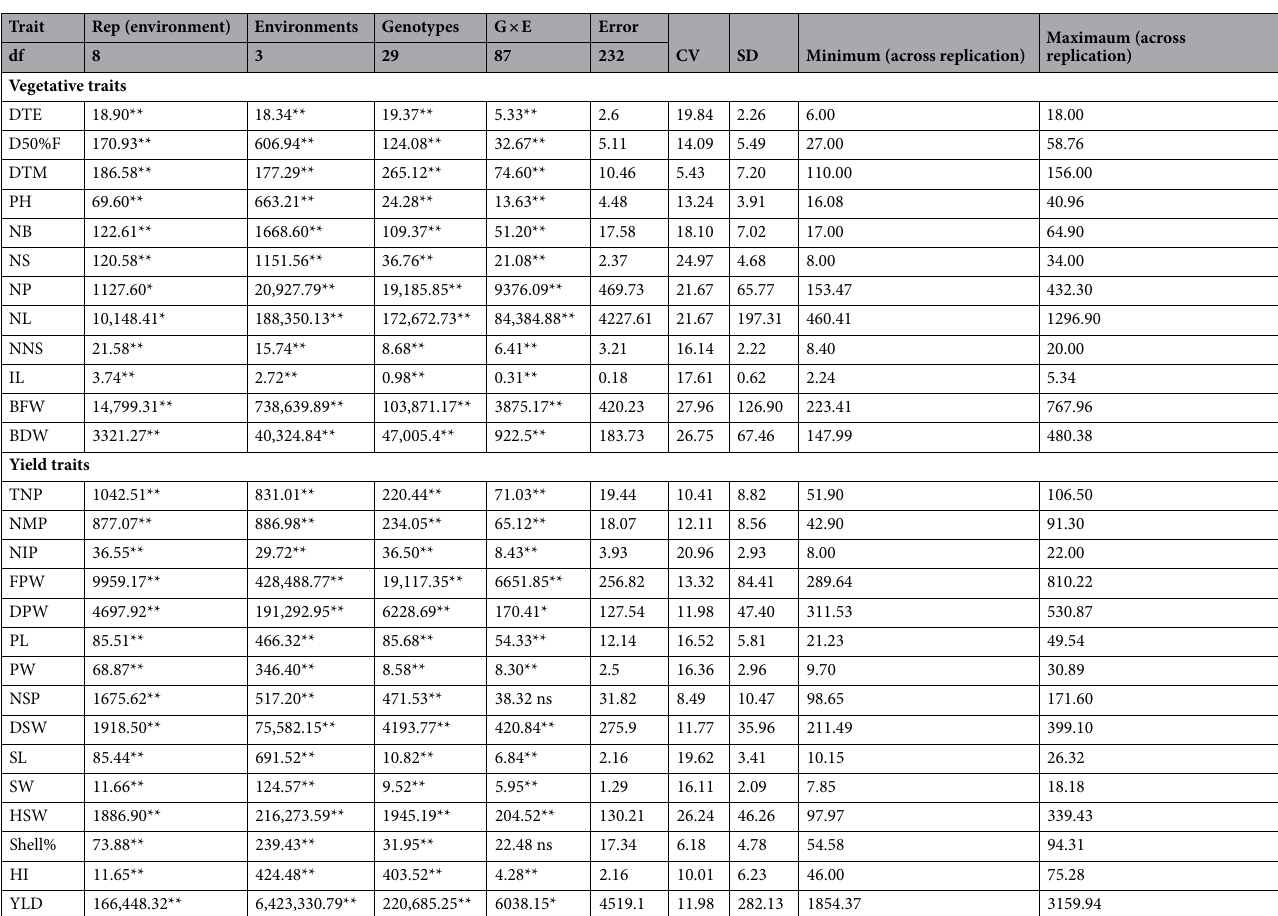
Table 6. Mean square for growth and yield traits of 30 Bambara groundnut accessions revealed by ANOVA. “**” correlation is significant at the 0.01 level; “*” correlation is significant at the 0.05 level, SD standard deviation, CV coefficient of variation (%), DTE (day) Days to emergence, Days to 50% flowering (day), DTM Days to maturity (day), PH Plant height (cm), NB Number of branches per plant, NS Number of stems per plant, NP Number of petioles per plant, NL Number of leaves per plant, NNS No. of nodes per stem, IL Inter nodes length (cm), BFW Biomass fresh weight per plant (g), BDW Biomass dry weight per plant (g), TNP Total no. of pods per plant, NMP Number of mature pods per plant, Number of Immature pods per plant, FPW Fresh pods weight (g), DPW Dry pods weight (g), PL Pod length (mm), PW Pod width (mm), NSP Number of seeds per plant, DSW Dry seed weight per Plant (g), SL Seed length (mm), SW Seed width (mm), HSW hundred seed weight (g), Shell % Shelling percent, HI Harvest index (%) and Yld Yield